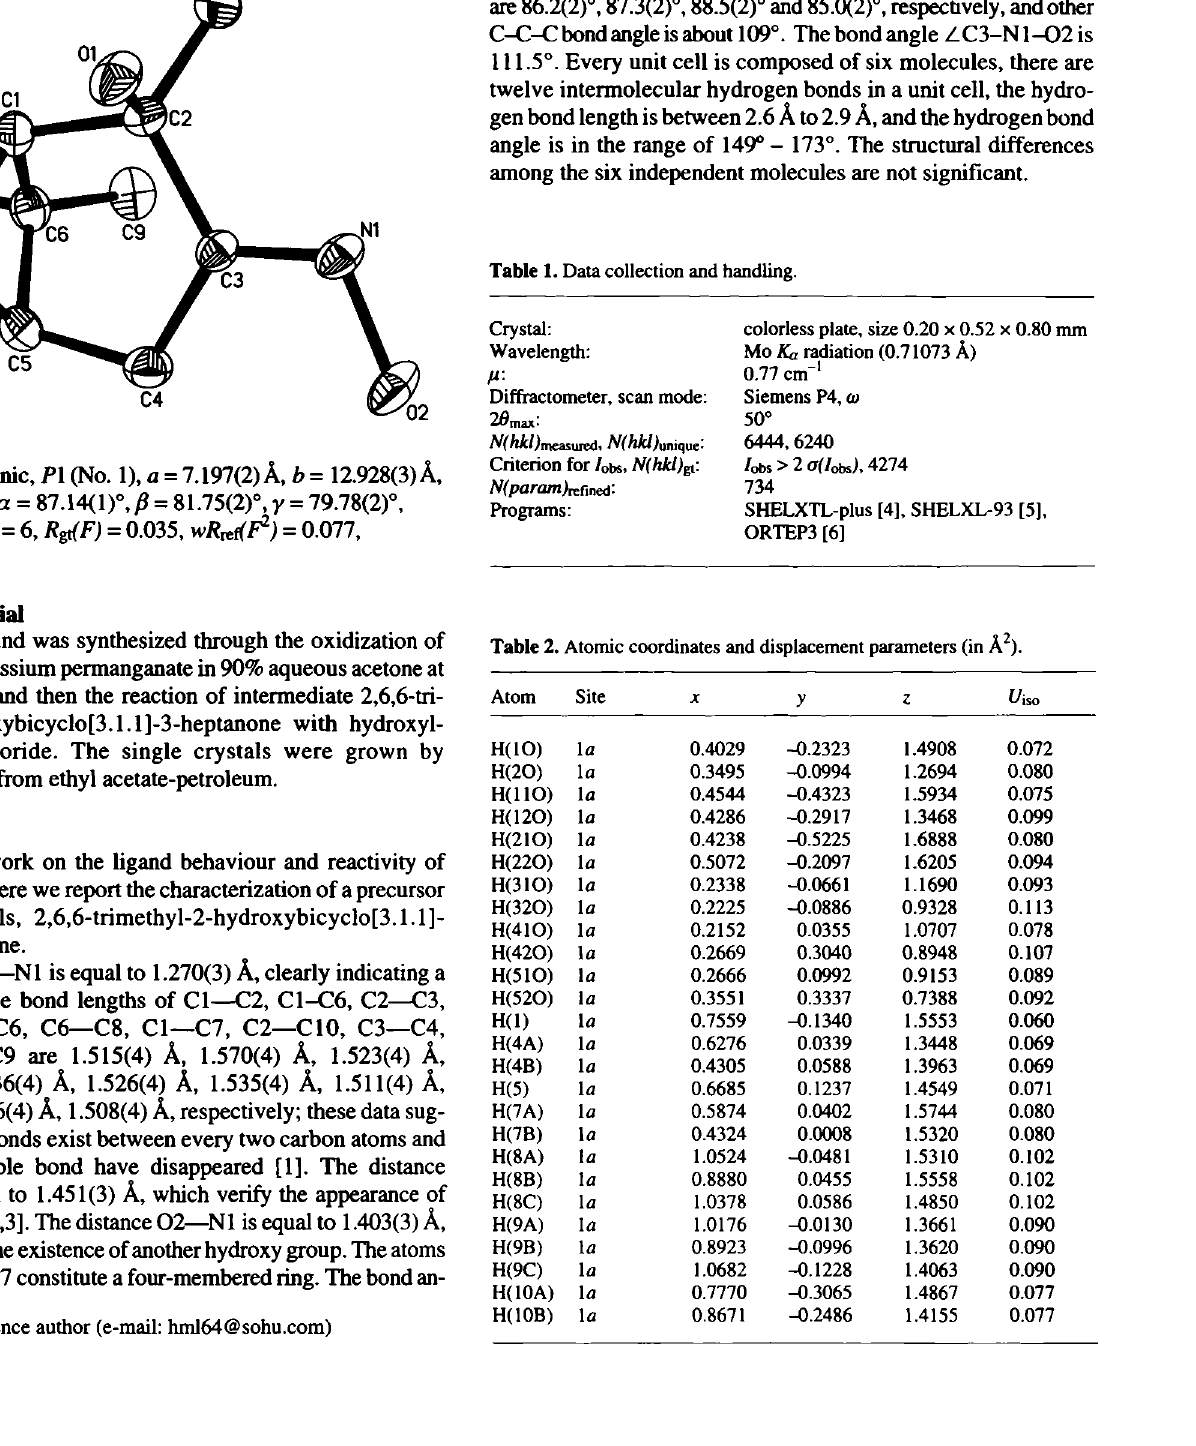
Table 1. Data collection and handling.